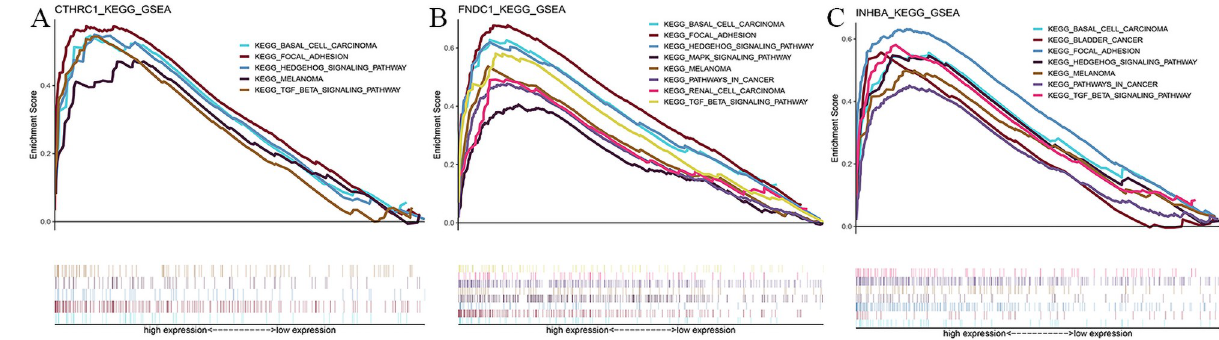
Fig 8. KEGG-GSEA analyses of the 3 identified hub genes. (A) CTHRC1 (B) FNDC1 (C)